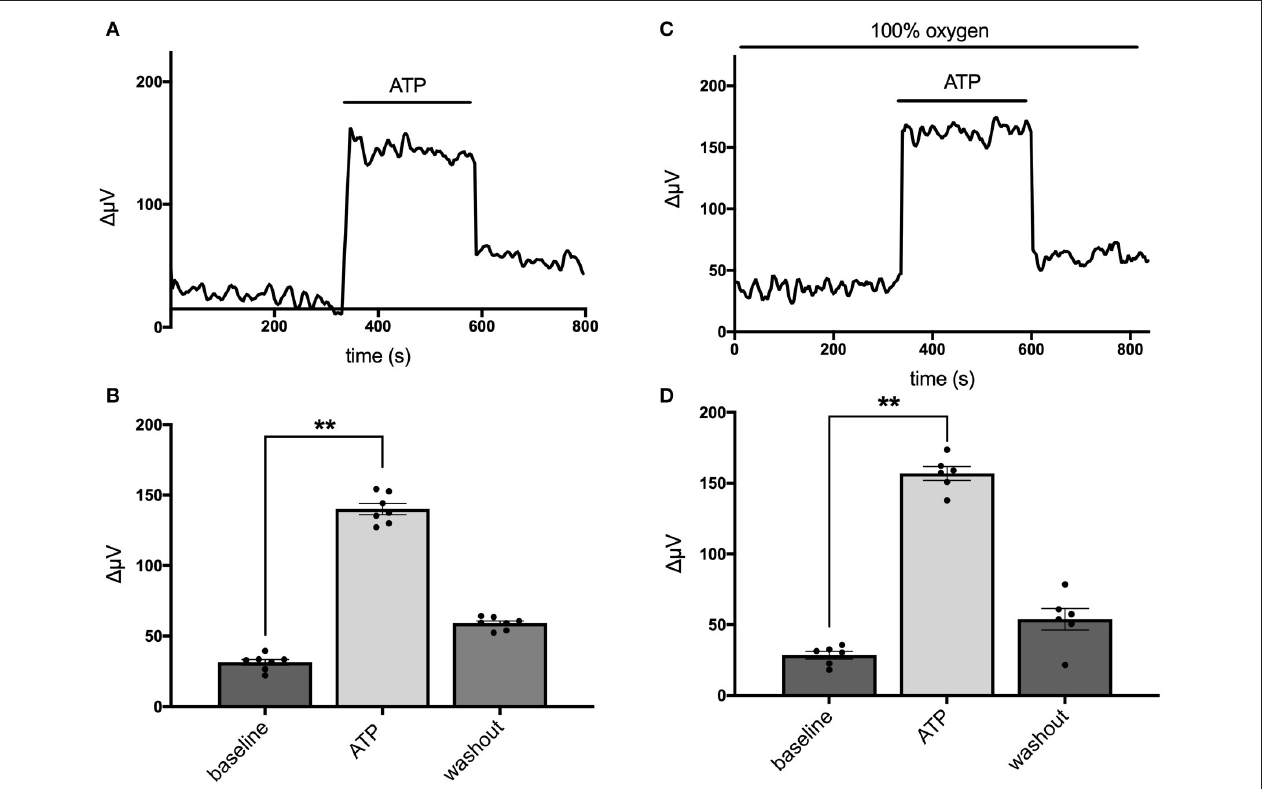
FIGURE 3 | Responses of cells from cryopreserved mouse hippocampal cultures to 100 µ M ATP bathed in a saline solution containing 1mM HEPES and saturated either with normal air or 100% oxygen. (A) Trace from one cell maintained in normal air in standing saline followed by application and then removal of 100 µ M ATP. (B) Quantitative data averaged from cells in normal air; N = 6. (C) Trace of H + flux signal from one cell maintained in 100% oxygen. (D) Quantitative data of H + signals obtained from cells in saline containing 100% oxygen; N = 7. **indicates P <